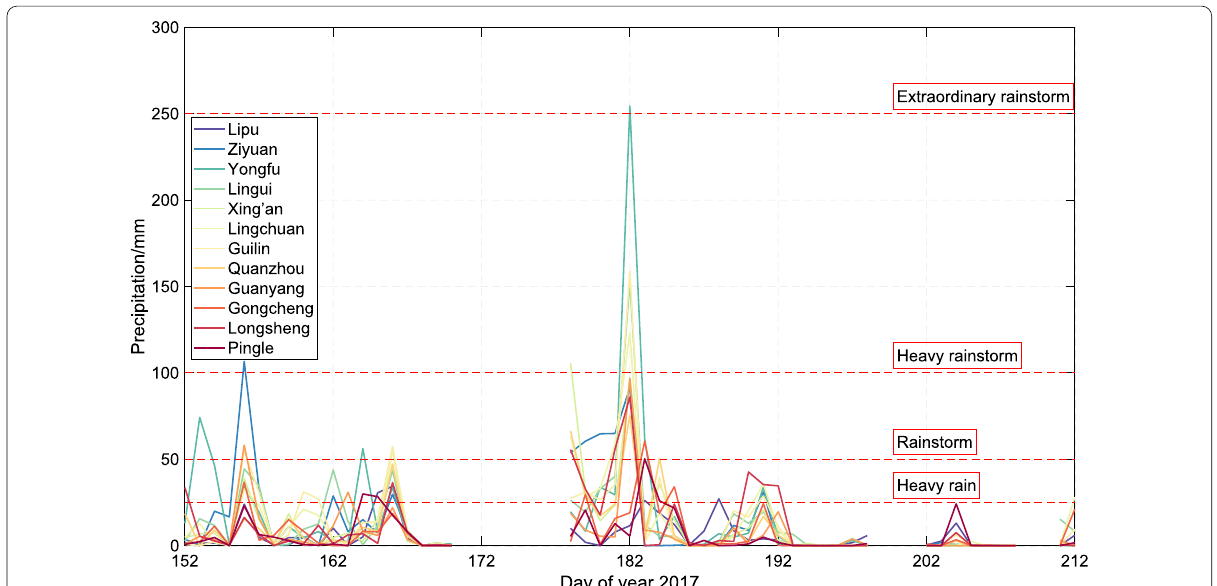
Fig. 6 Daily precipitation observed at 12 MET stations in Guilin from June to July 2017 (red dashed lines represent the classification of